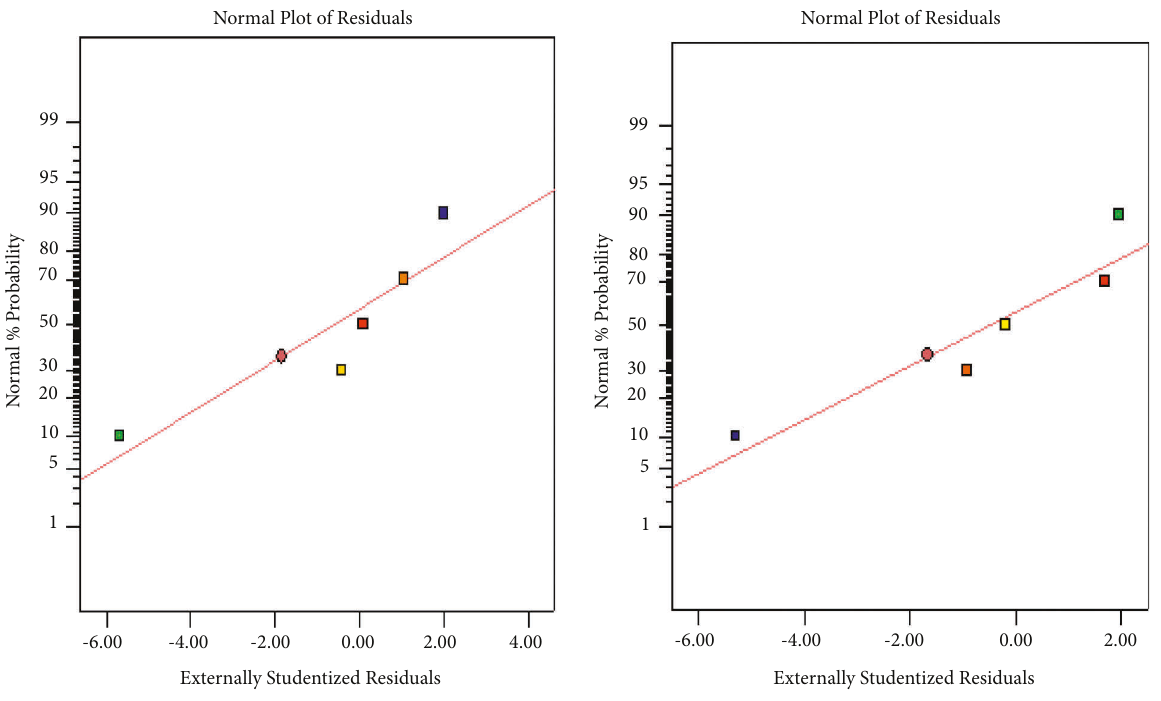
Figure 8: Residuals normal probability plots for the target responses.